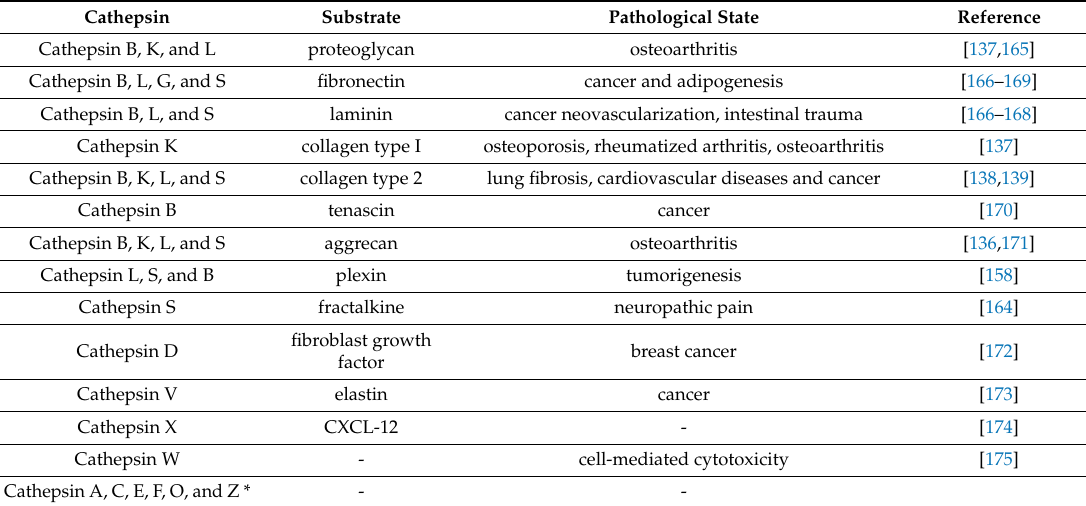
Table 3. Cathepsins in the extracellular